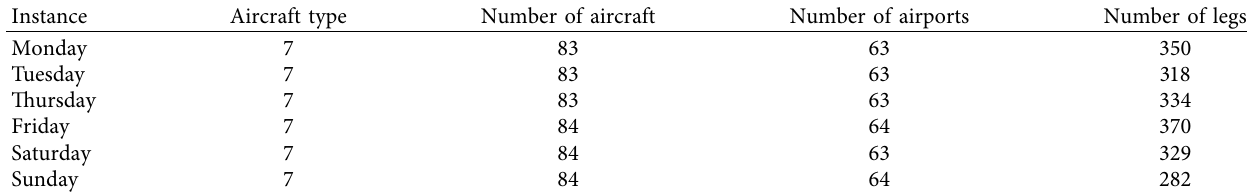
Table 4: Data information.